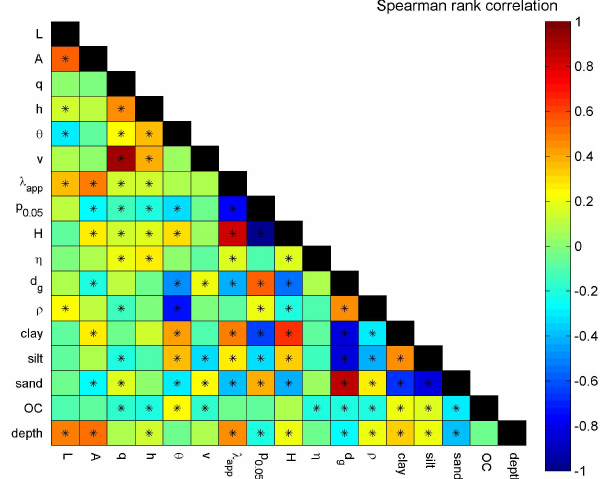
Fig. 3. Spearman rank correlation coefficients between various BTC-shape measures and soil and site as well as experimental prop- erties. The boxes marked by an asterisk indicate significant cor- relations with p -values smaller than 0.001. The correlations were carried out for the travel distance, L , the area of the breakthrough plane, A , the water flux, q , the suction head, h , the water content, θ , the transport velocity, v , the apparent dispersivity, λ app , the nor- malized 5%-arrival time, p 0 . 05 , the holdback, H, the piston-flow to transport velocity ratio, η , the geometric mean grain diameter, d g , the soil bulk density, ρ , the clay fraction, clay, the silt fraction, silt, the sand fraction, sand, the organic carbon content, OC, the average sampling depth, and